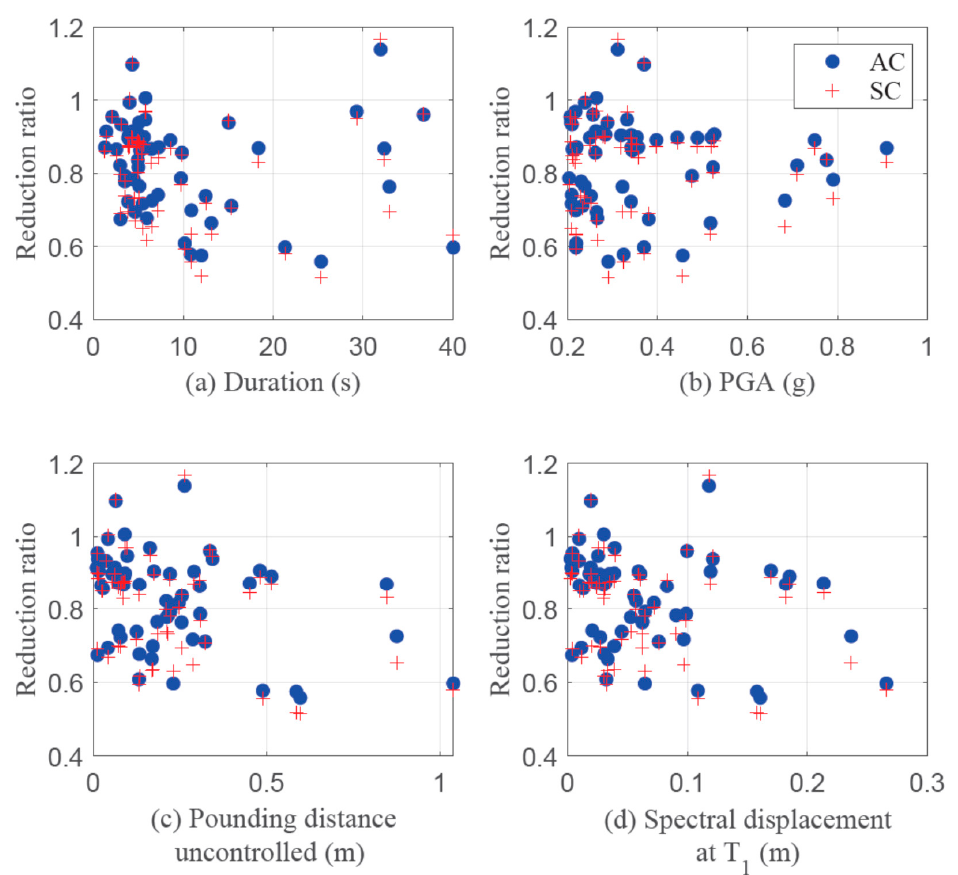
Figure 8. Effectiveness of tuned mass dampers in reducing the minimum separation distance to prevent pounding. The variation of effectiveness with different ground motion parameters is presented for those ground motion whose PGA is larger than 20% of acceleration due to gravity.